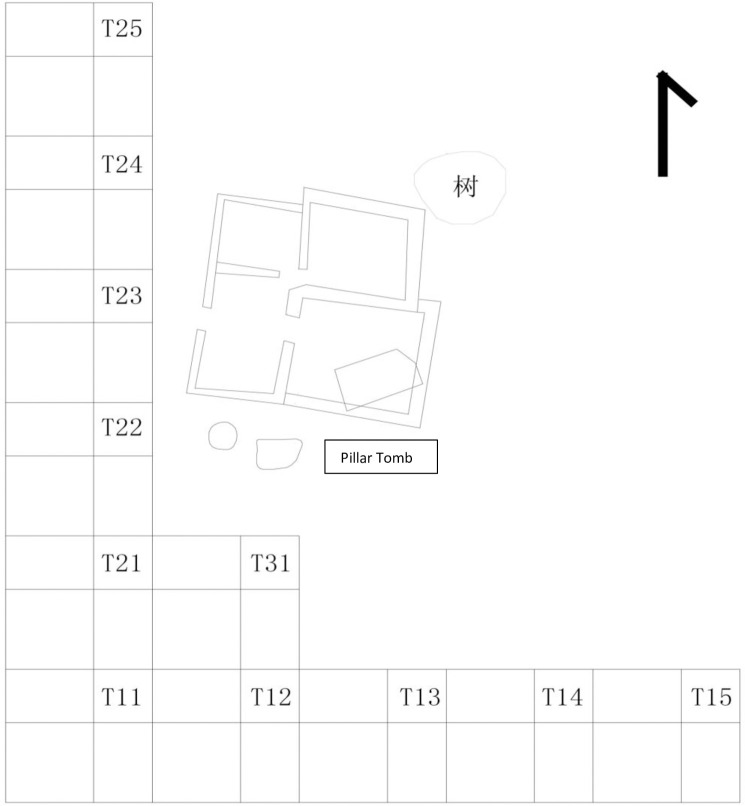
Excavated area of MA in Mambrui, Kenya.Excavation plan of Area MA in Mambrui. Most of the glass beads from Mambrui came from Area MA T12, 21 and 24.